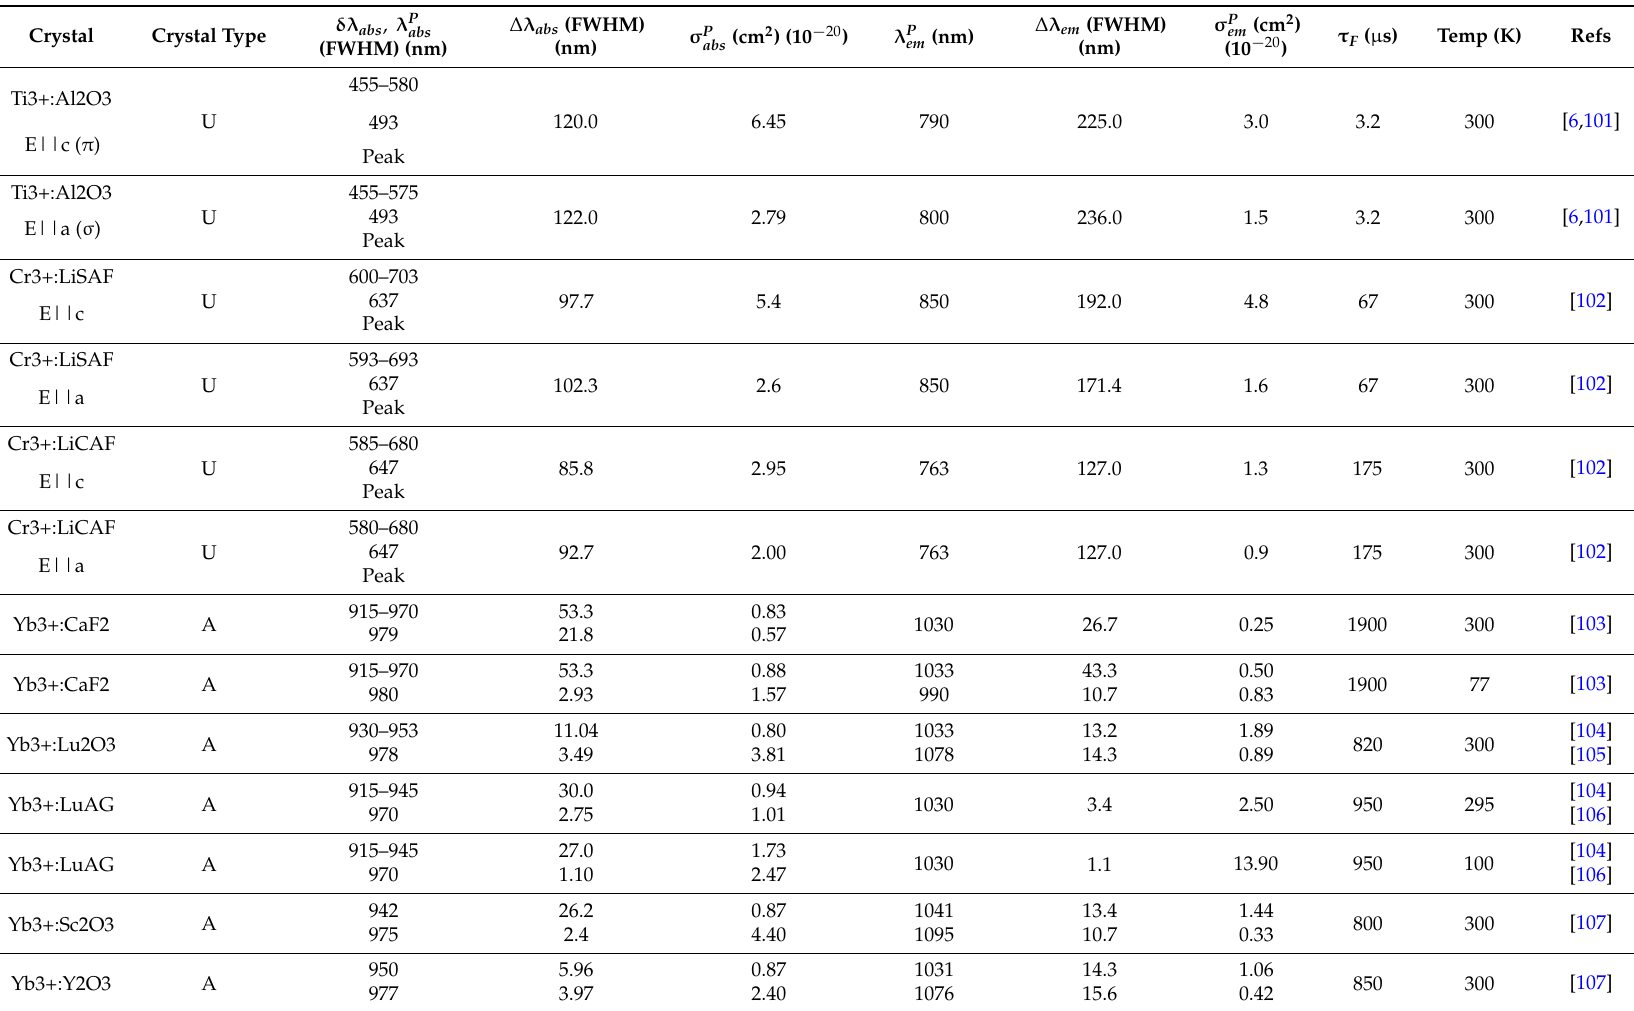
Table 6. Spectral properties of legacy and Yb-based ultrafast laser materials at room and cryogenic